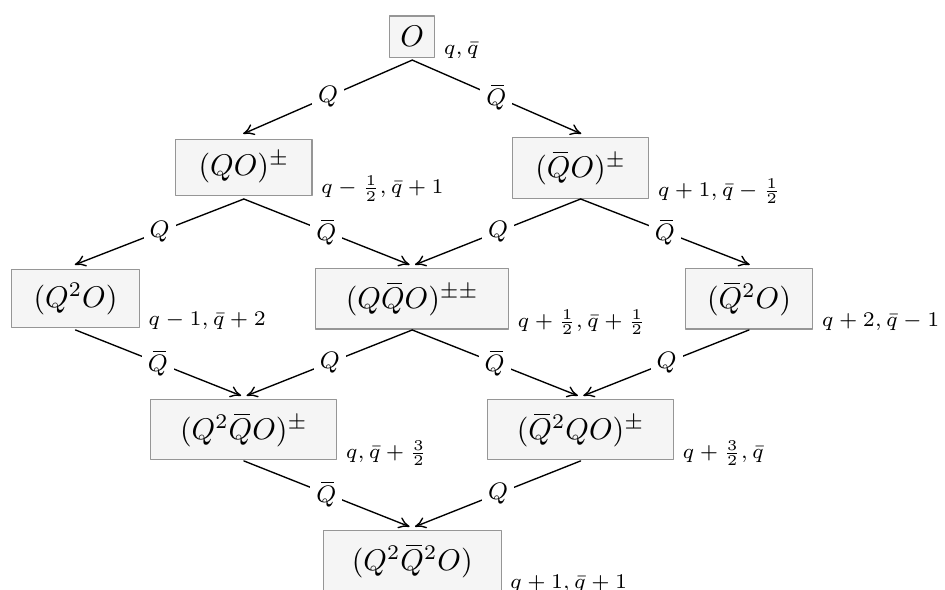
Figure 1 . Diagram of all operators in an N = 1 long multiplet. Superscripts of (cid:6) indicate the choice of spin j (cid:6) 1 or (cid:22) | (cid:6) 1. Subscripts indicate the q; (cid:22) q charges. The R-charge grows from left to right by 1 and the conformal dimension grows from top to bottom by 1 = 2. A box represents the full tower of descendants O; @ (cid:22) O; @ 2 O; : :